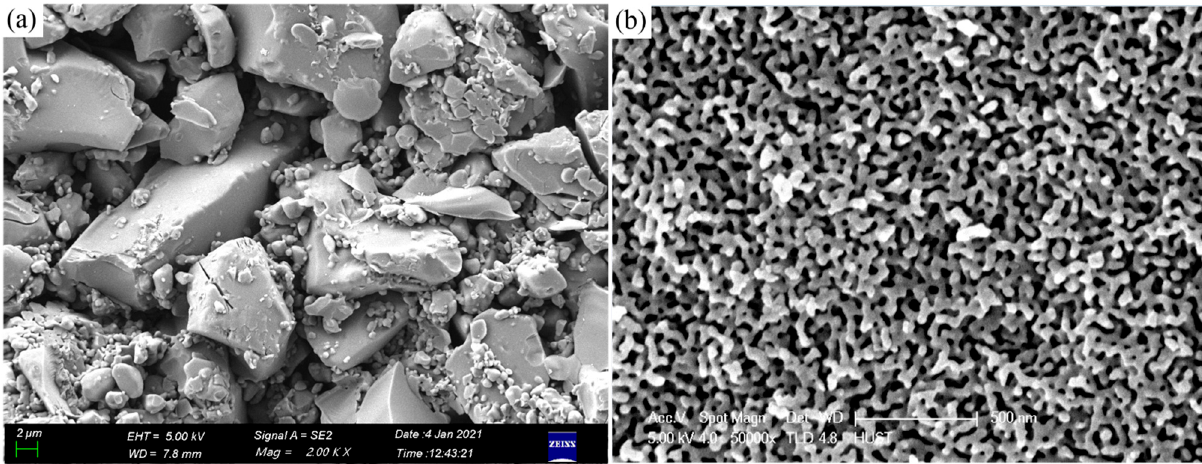
Figure 2. ( a ) Powder-sintered borosilicate glass and ( b ) phase-separation porous borosilicate glass image.